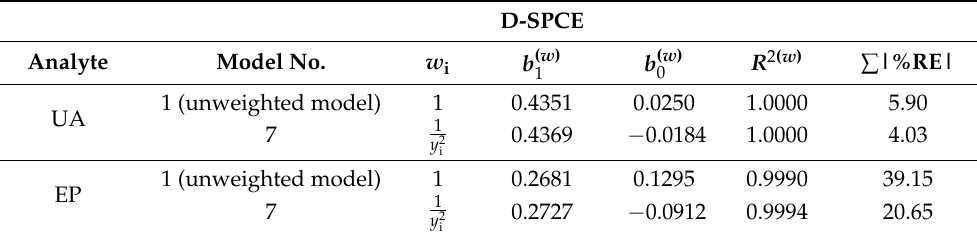
Table 3. A comparison between unweighted model 1 (OLS method) and the best weighted model, i.e., model 7 (WLR method), with weighted regression parameters and ∑ | %RE | for UA and